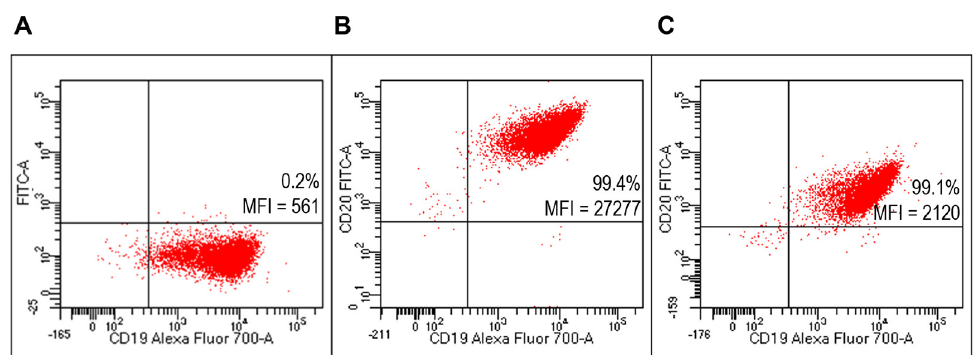
Figure 5. Evaluation of FITC-Ritux Fab functionalized liposomes on Raji cells (B-cell lymphoma line). Representative FACS profiles indicating the MFI values of FITC-Ritux Fab among Raji cells. Cells were stained with the anti-CD19-Alexa Fluor 700 ( A ) and FITC-Ritux Fab ( B ) or liposomes functionalized with Ritux Fab /FITC-Ritux Fab (90/10 mol/mol) ( C ).